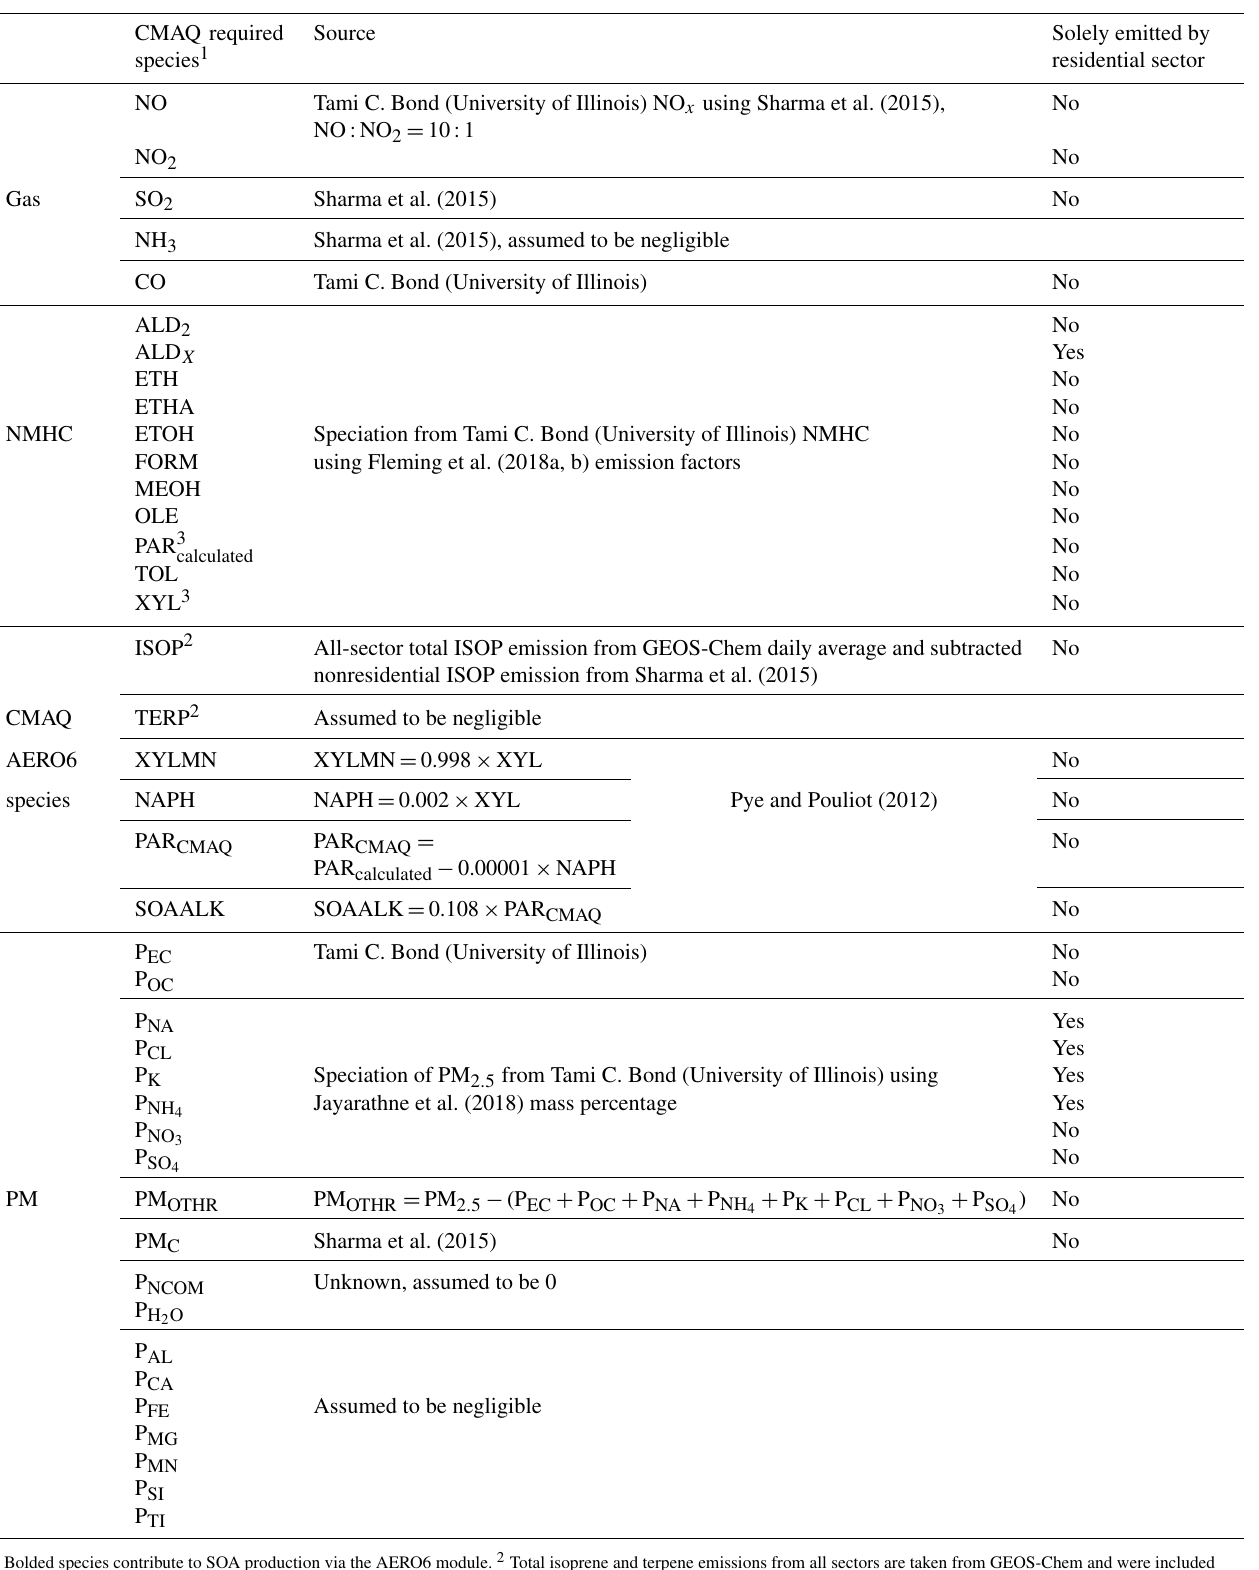
Table 1. Residential emissions inventory sources by